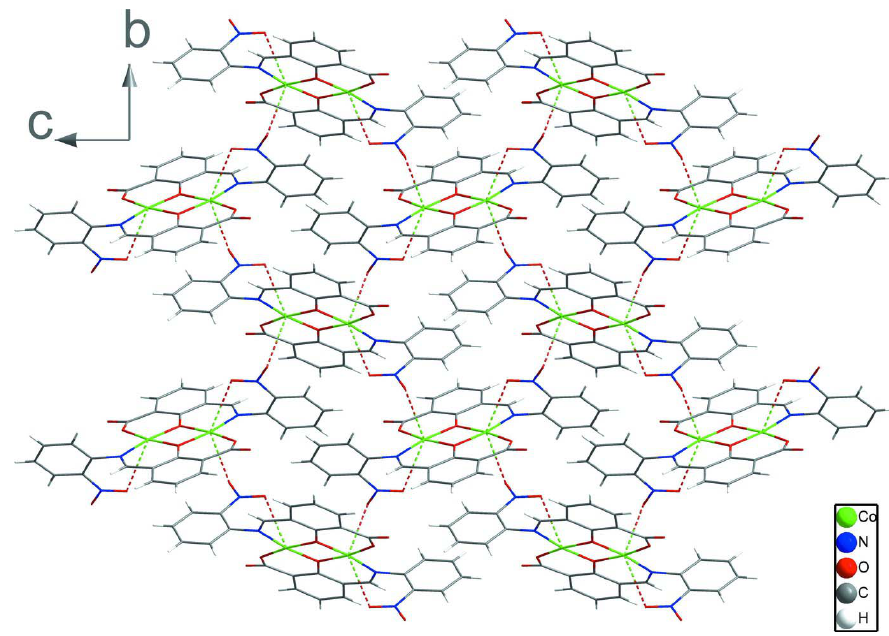
Figure 2 View along the a -axis of the two-dimensional network of complex (I).